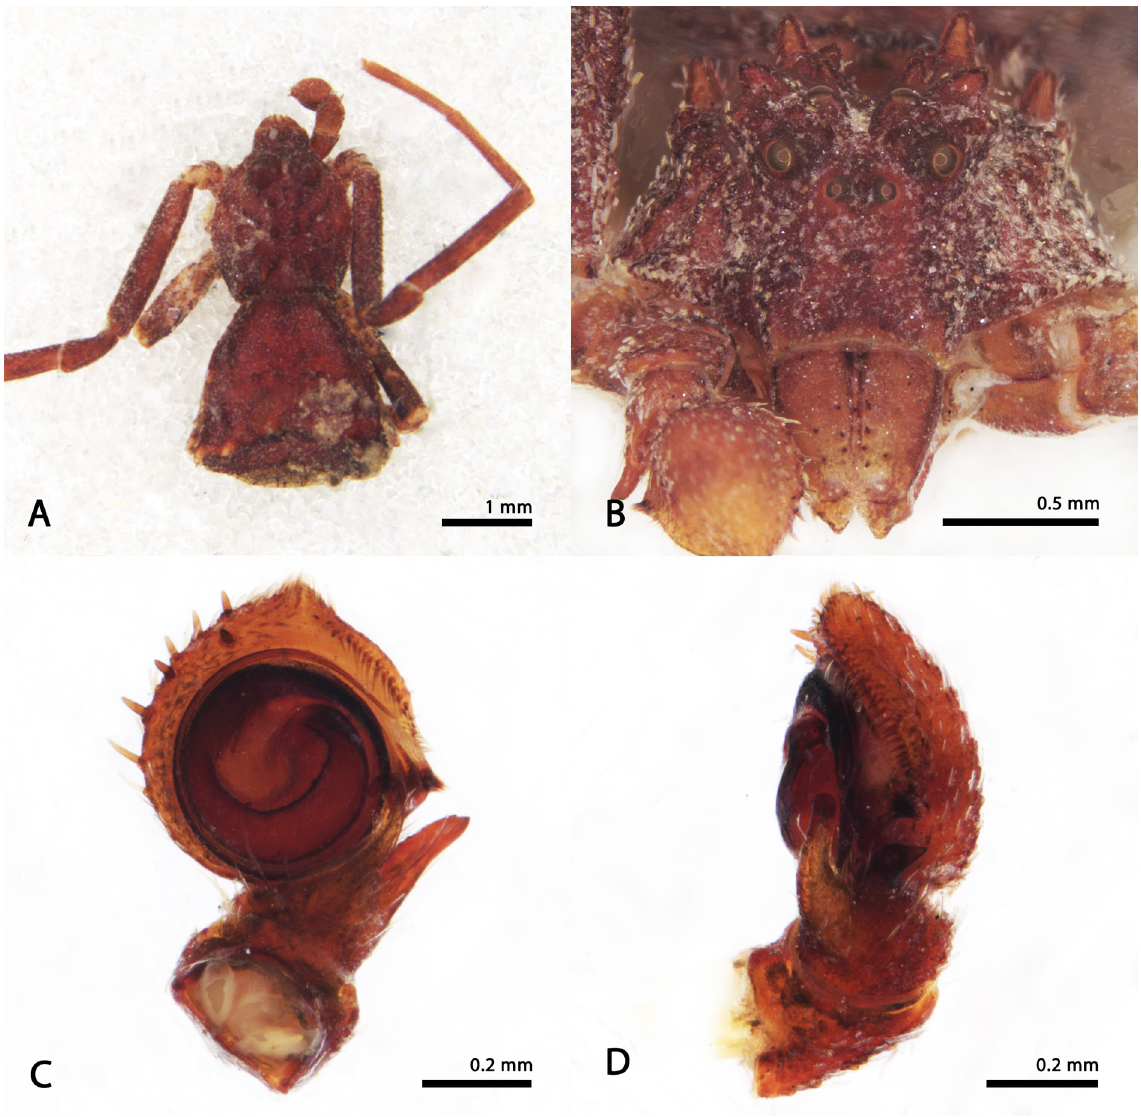
Fig. 25. Stephanopis quimiliensis Mello-Leitão, 1942. Holotype, ♂ (MLP 15455). A . Habitus, dorsal view. B . Front. C–D . Left palp. C . Ventral view. D . Retrolateral